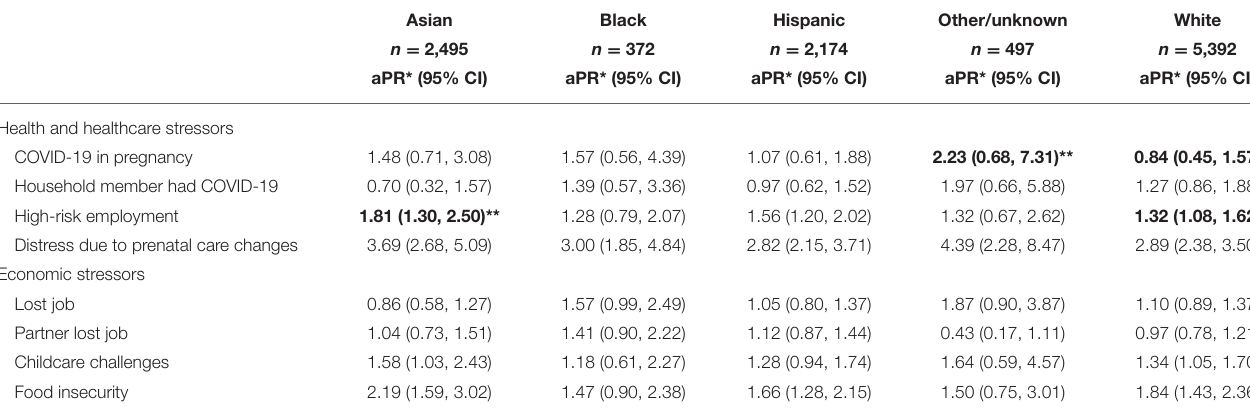
TABLE 3B | Adjusted prevalence ratio (aPR) for the relationship between COVID-19-related health/healthcare and economic stressors and prenatal anxiety, stratified by racial and ethnic category.